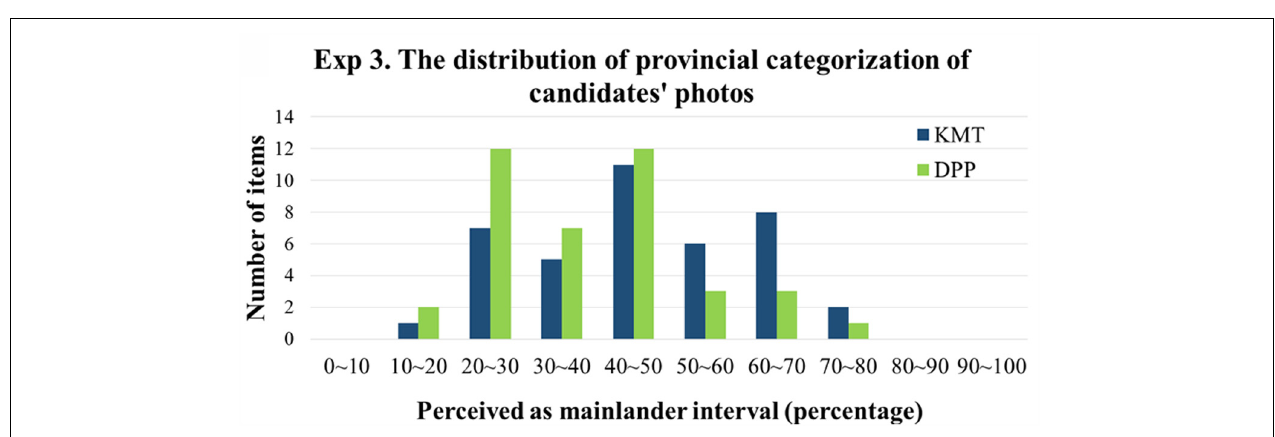
FIGURE 6 | The distribution of provincial appearance categorization in Experiment 3, measured by the percentage of perceived as mainlander collapsed across participants. The abscissa denotes the provincial appearance categorization tendency as mainlanders of the candidates’ photos in 10% bins the ordinate denotes the number of photos. The item that falls above 50% means that more than half of the participants perceive the photo as resembling mainlander. The item that falls below 50% means that more than half of the participants perceive the photo as resembling native